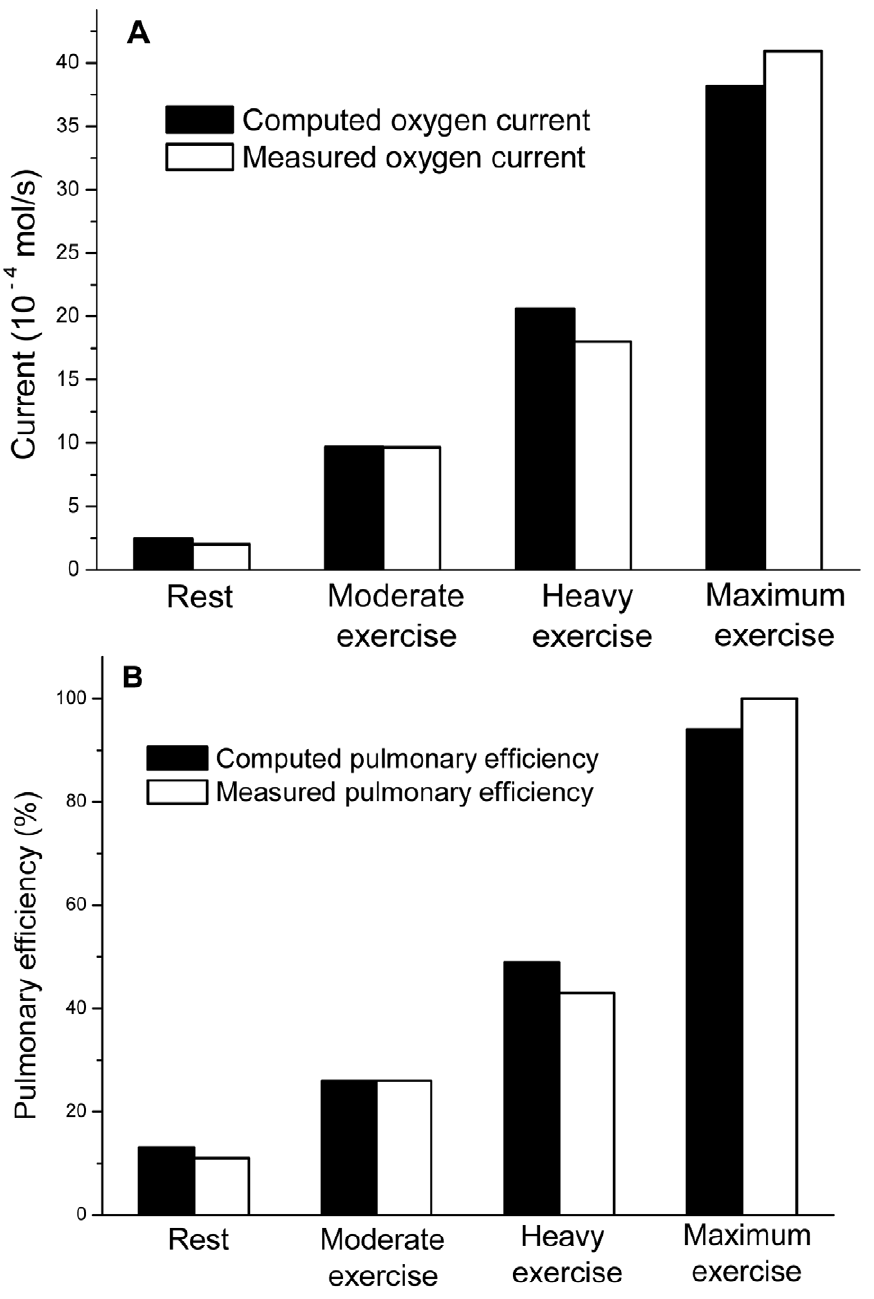
Figure 3. Computed and experimental oxygen currents and pulmonary efficiencies. (A) Computed and experimental O 2 currents for the whole lung and (B) pulmonary efficiencies, at different levels of exercise (levels of exercise are defined in the Methods section). The currents are computed from Eqs. 4 and 5. The computed pulmonary efficiency is obtained from Eqs. 5 and 7a, and the experimental value of the efficiency is obtained from Eq. 7c. In this figure, we compute the oxygen current with the physiological permeability, so instead of treating W as a variable, we take W = W p (Table 1). Other transport parameters in the equations are listed in Table 1. The structural parameters at different levels of exercise are listed in Table 2 (column 2, 3, 4, and 5). The fractal dimension, D f , is taken to be